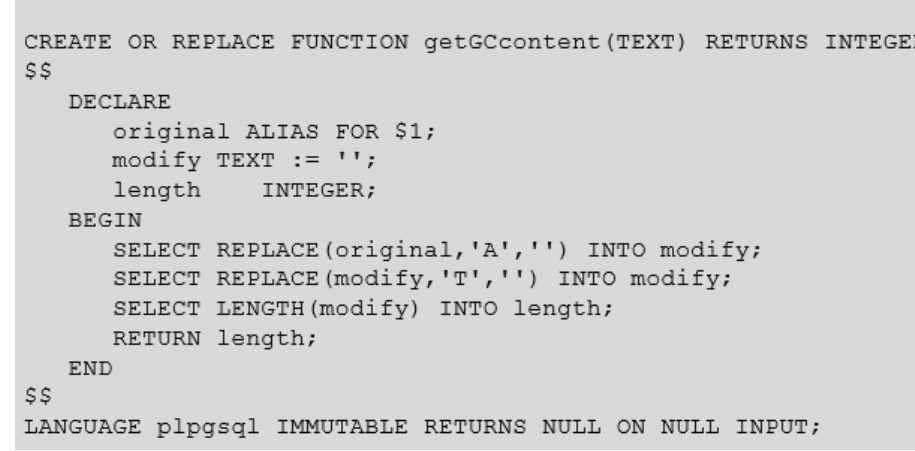
Figure 5. GC Content Relational